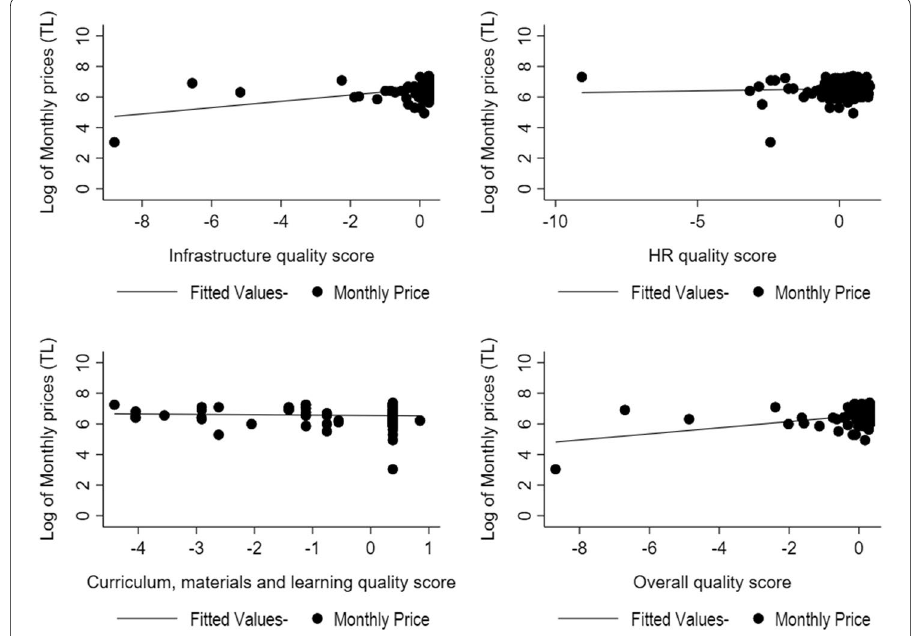
Fig. 1 Log of monthly child care prices and quality scores. HR refers to human